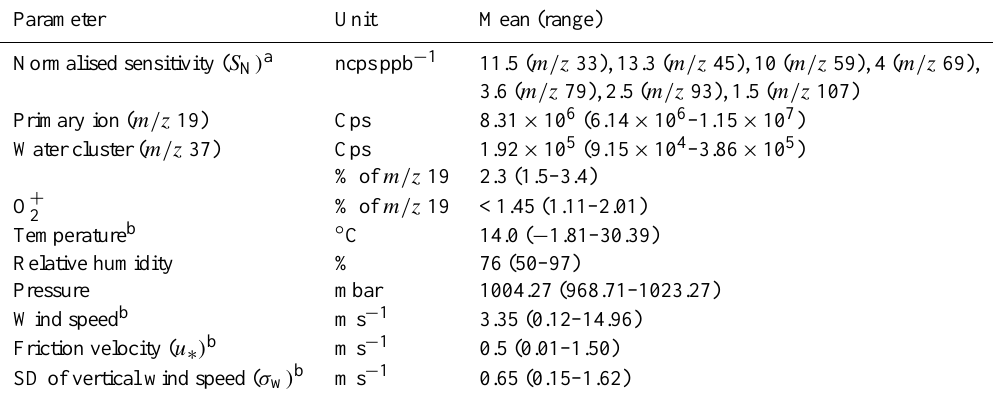
Table 1. Summary of instrument operating parameters and average meteorological conditions during the measurements in central London, August–December